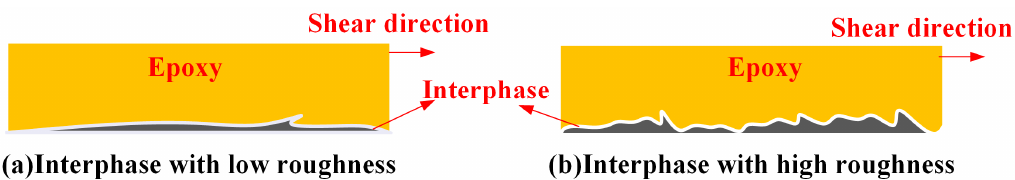
Figure 9. Schematic diagram of shear deformation of nanocomposite along longitudinal direction under di ff erent interface roughness.